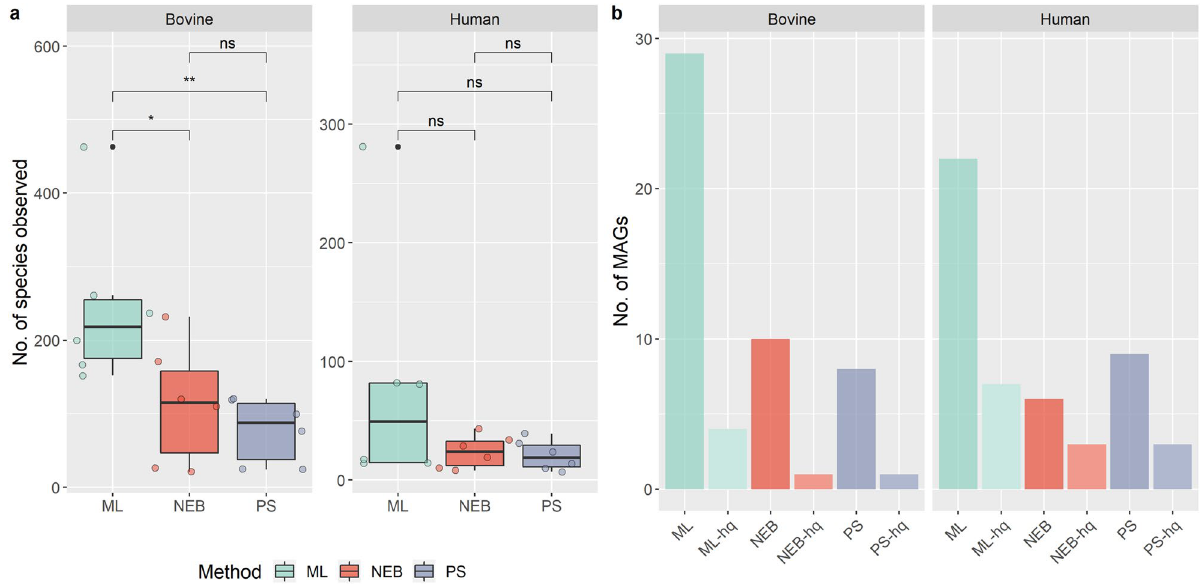
Figure 5. ML kit generated higher numbers of observable species and metagenome assembled genomes in milk samples. ( a ) Total number of species detected by each method in either bovine (left) or human (right) milk samples. A single or double asterisk indicates a significant (P < 0.05) or highly significant (P < 0.01) difference between species number as determined by ANOVA. ( b ) The number of total and high-quality MAGs (hq) recovered from sequenced samples using either method. High-quality MAGs were greater than 90% completeness and less than 5% contamination. Figures were produced using R 48